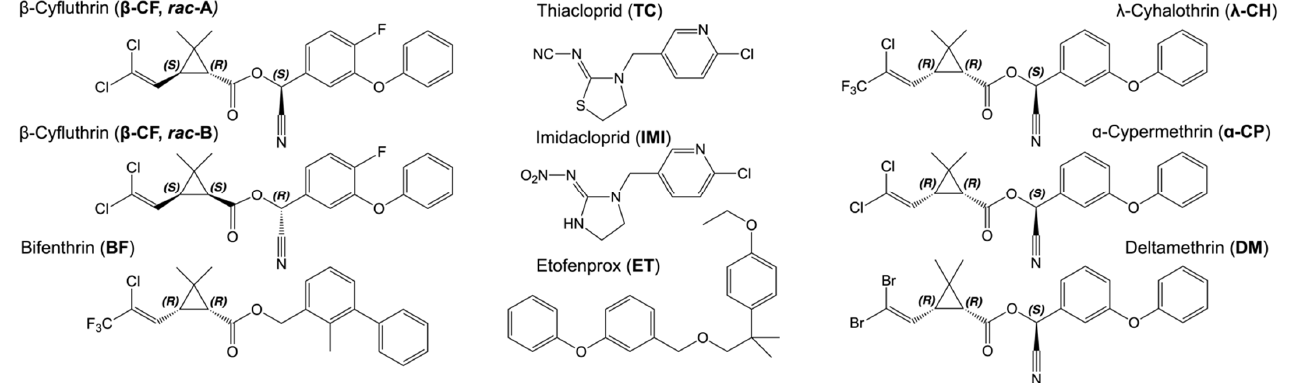
Figure 2. Molecular structures of the insecticides discussed herein. Notes on stereochemistry: Configurations of stereogenic centers are read directly in structures above from left to right throughout, a shortcut past naming conventions that are cumbersome here. β -cyfluthrin ( β -CF): SRS -enantiomer shown in racemic mixture A ( rac -A), and the SSR -enantiomer in racemic mixture B ( rac -B). Bifenthrin (BF): RR -enantiomer of a racemic mixture is shown. λ -cyhalothrin ( λ -CH): RRS -enantiomer of a racemic mixture is shown. α -cypermethrin ( α -CP): RRS -enantiomer of racemic mixture shown. Deltamethrin (DM, RRS stereoisomer) is enantiomerically pure.